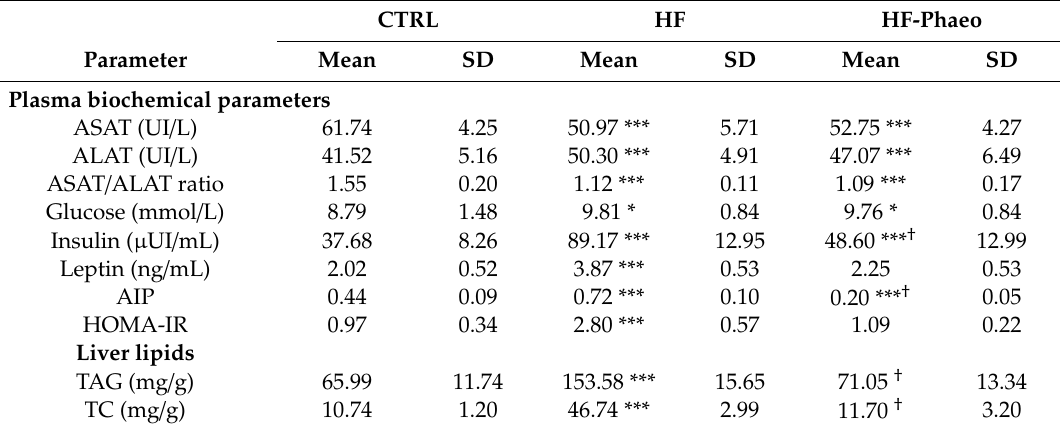
Table 5. Plasma biochemical parameters and liver lipid